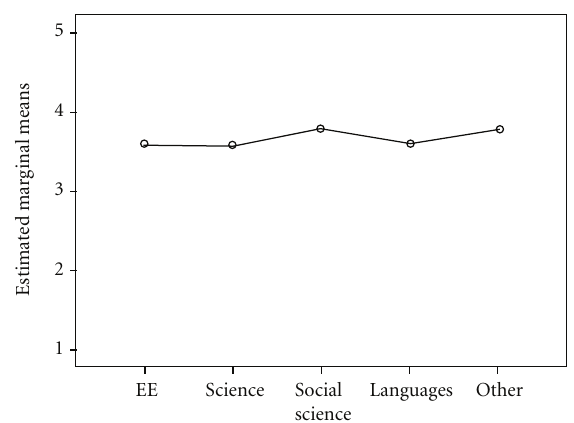
Figure 3: 7 Identifying consequences of actions and options. Estimated Marginal means of 7 identifying the consequences of actions and